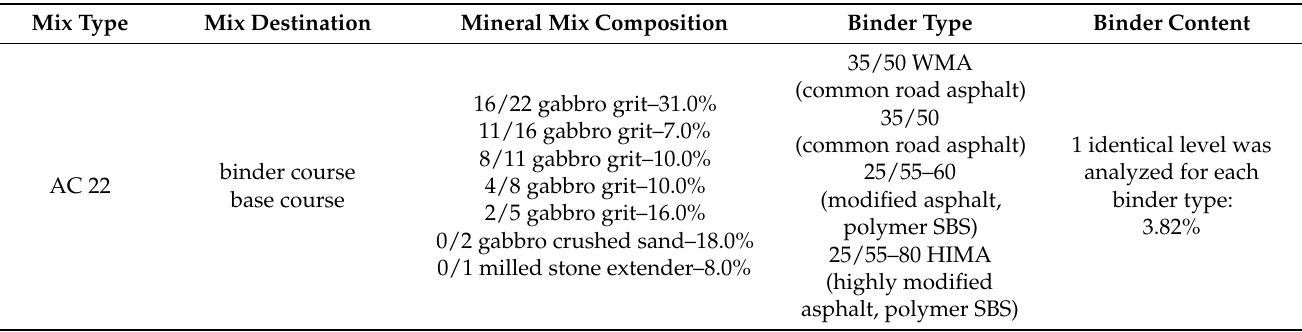
Table 1. Mineral asphalt mix